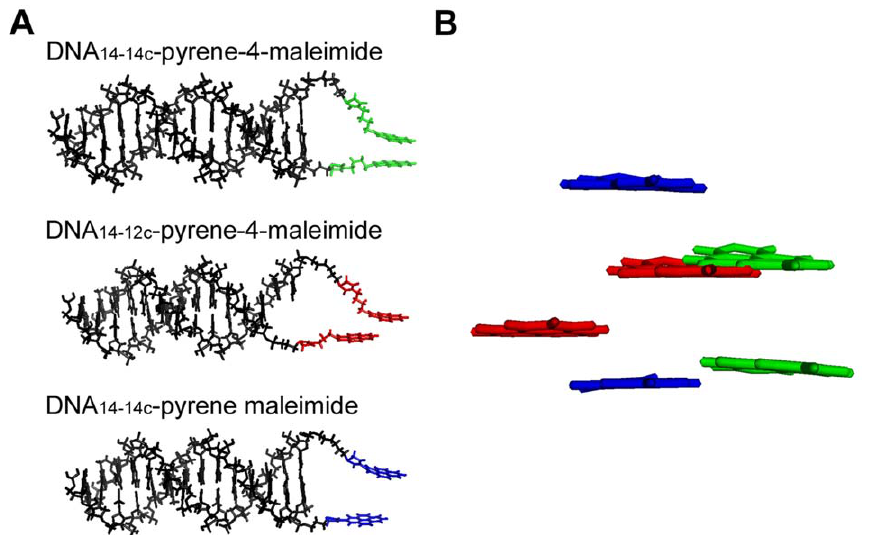
Figure 4. Double-stranded DNA models with pyrene maleimides attached via thiol linkers. A. Stick representation view along the DNA long axis. Pyrene-4-maleimide attached to DNA 14-14c and DNA 14-12c is shown in green and red, respectively. Pyrene maleimide attached to DNA 14-14c is shown in blue. The 5 9 thiol was present in the 14-bp long strand in all cases. The 3 9 thiol was present in the 14-bp or 12-bp long complementary strands. B. Stick representation view perpendicular to that in panel A. Only the pyrenes are shown for clarity. Color coding as in panel A. See Materials and Methods for details.